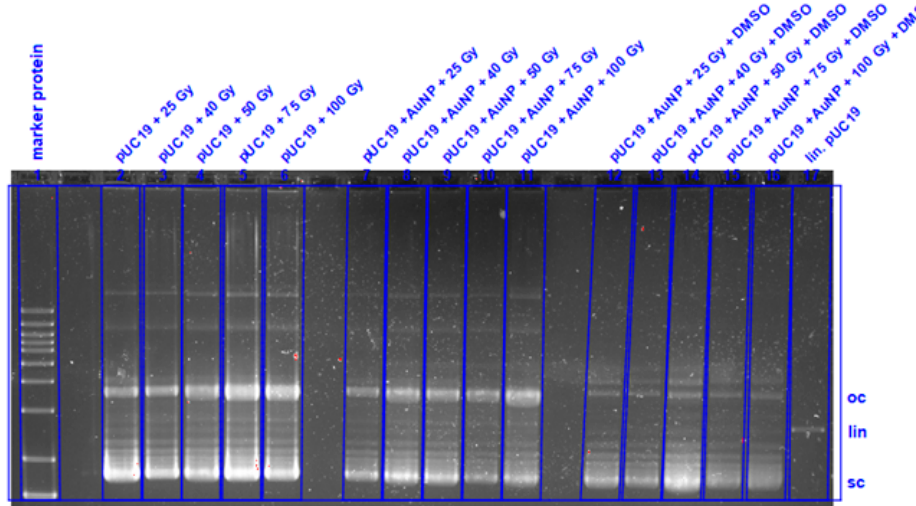
Figure A17. Evaluation of the irradiation experiments using X-ray in combination with AuNP 1 via gel electrophoresis. Left line is the marker protein. The lowest bands show intact sc-DNA, middle bands show lin-DNA with DSBs, and the highest band show oc-DNA with SSBs. The direction of elution is from top to bottom.